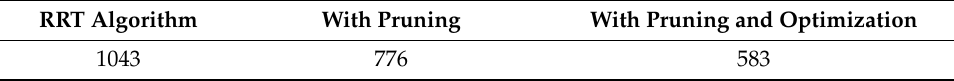
Table 2. The average path length by the RRT algorithm, the improved algorithm with pruning, and the improved algorithm with pruning and